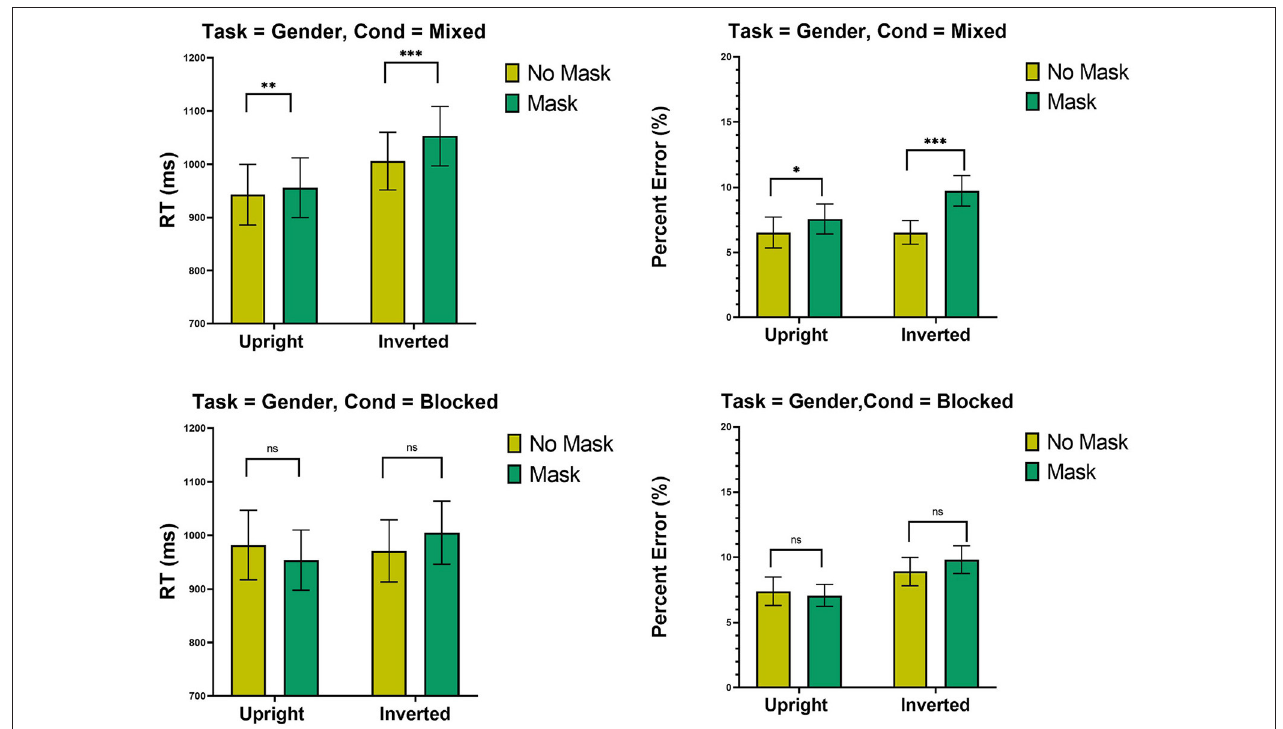
FIGURE 5 | Experiment 4: Mean RTs (ms) and percent error (%) as a function of mask (mask and no mask) and inversion (upright and inverted). Top panel: Mixed condition, bottom panel blocked condition. *** p < 0.001, ** p < 0.01, and * p < 0.05. Error bars are standard errors of the means.